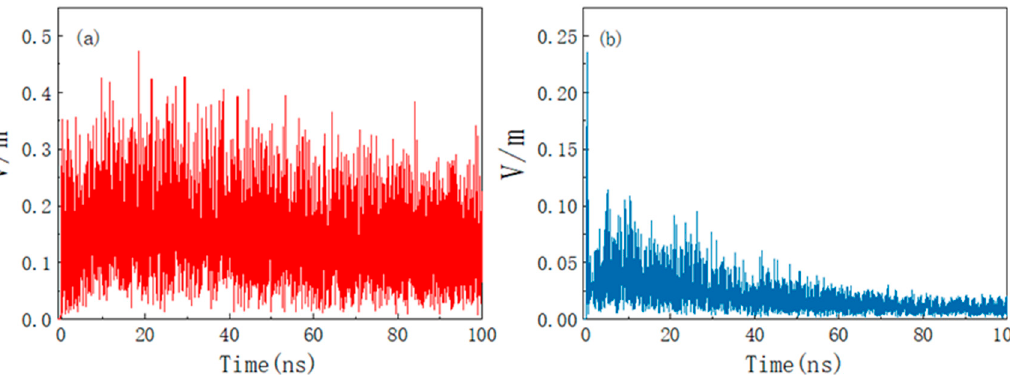
Figure 15. Electric field strength at the center of the product cavity under NEMP amplitude illumi- nation. ( a ) No absorbing material; ( b ) placement of absorbing material.